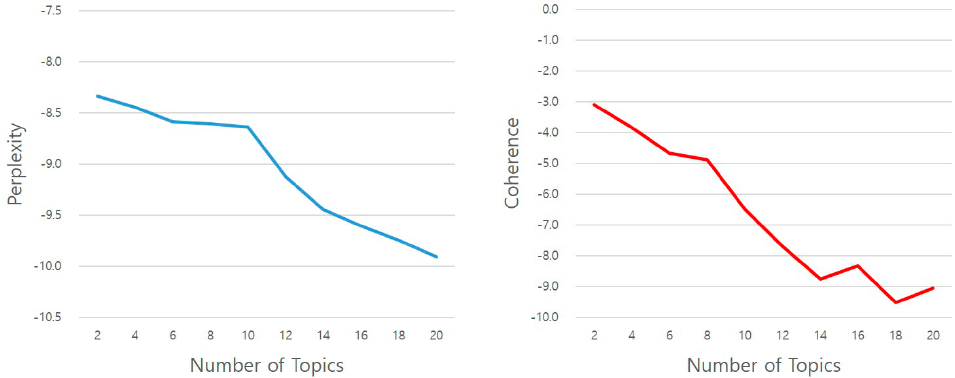
Figure 4. Example of graph of confusion score and consistency score according to the number of topics .